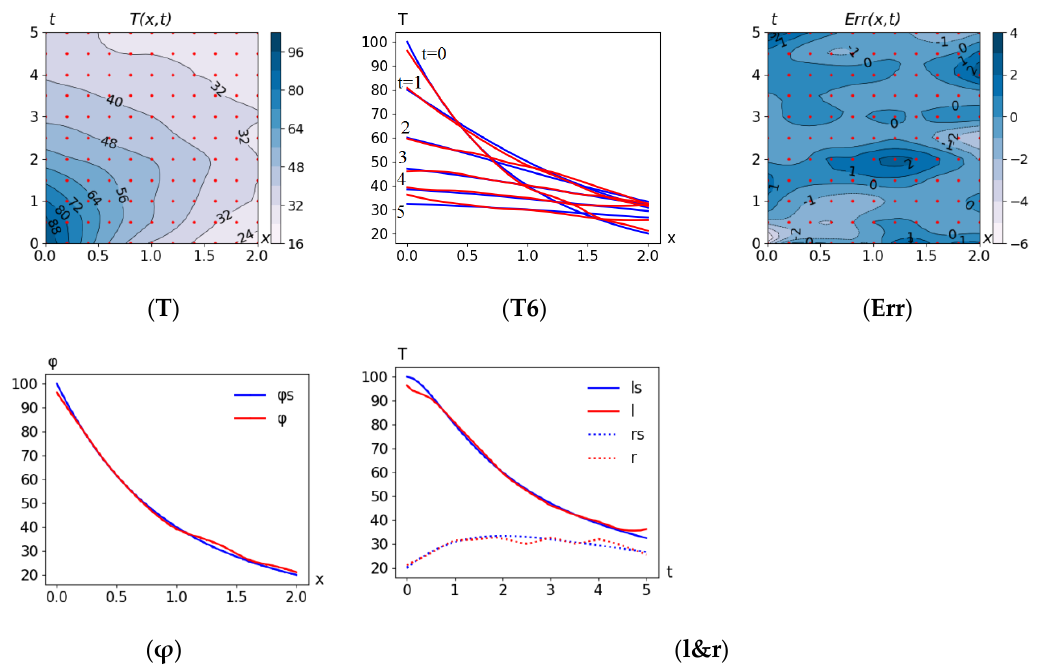
Figure 3. SvF solution of Problem 5.0: ( T ) contour lines of T ( x,t ); ( T6 ) 6 slices of T ( x,t ); ( Err ) Err ( x,t ) = T ( x,t ) − Ts ( x,t ) – deviation of the SvF solution from the exact solution; ( φ ) is the initial condition; ( l&r ) left and right boundary conditions.